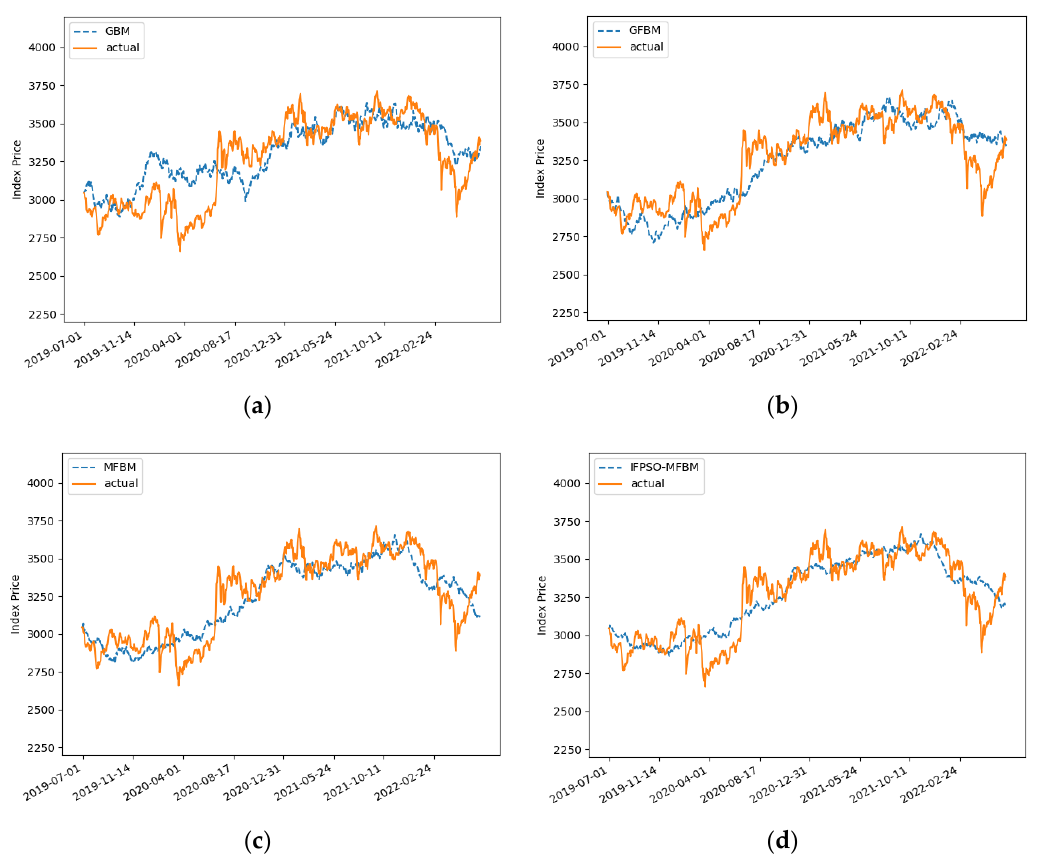
Figure 4. Comparison of the true and predicted values of SSE under the four models. ( a ) GBM, ( b ) GFBM, ( c ) MFBM, ( d ) IFPSO-MFBM. Table 4. Comparative error analysis of SSE index under four